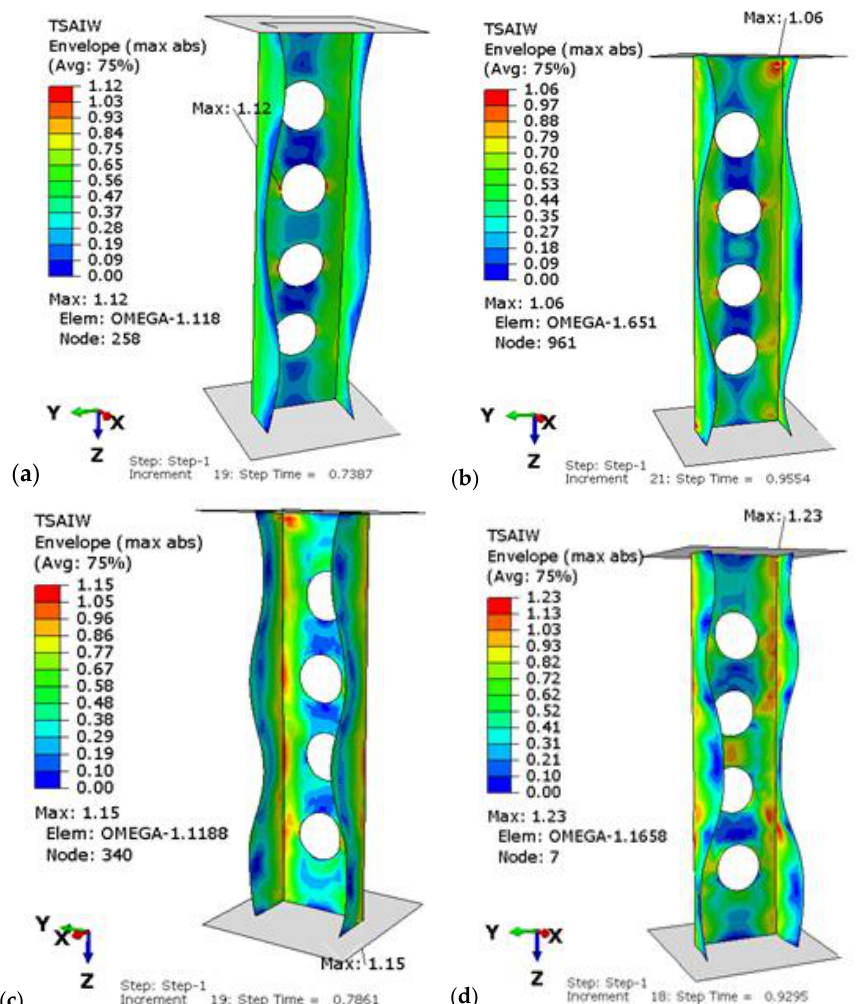
Figure 10. Tsai – Wu critical parameter map with the obtained form of loss of stability for the Figure 10. Tsai–Wu critical parameter map with the obtained form of loss of stability for the configu- configurations: ( a ) P1, ( b ) P2, ( c ) P3, ( d ) P4. rations: ( a ) P1, ( b ) P2, ( c ) P3, ( d ) P4.